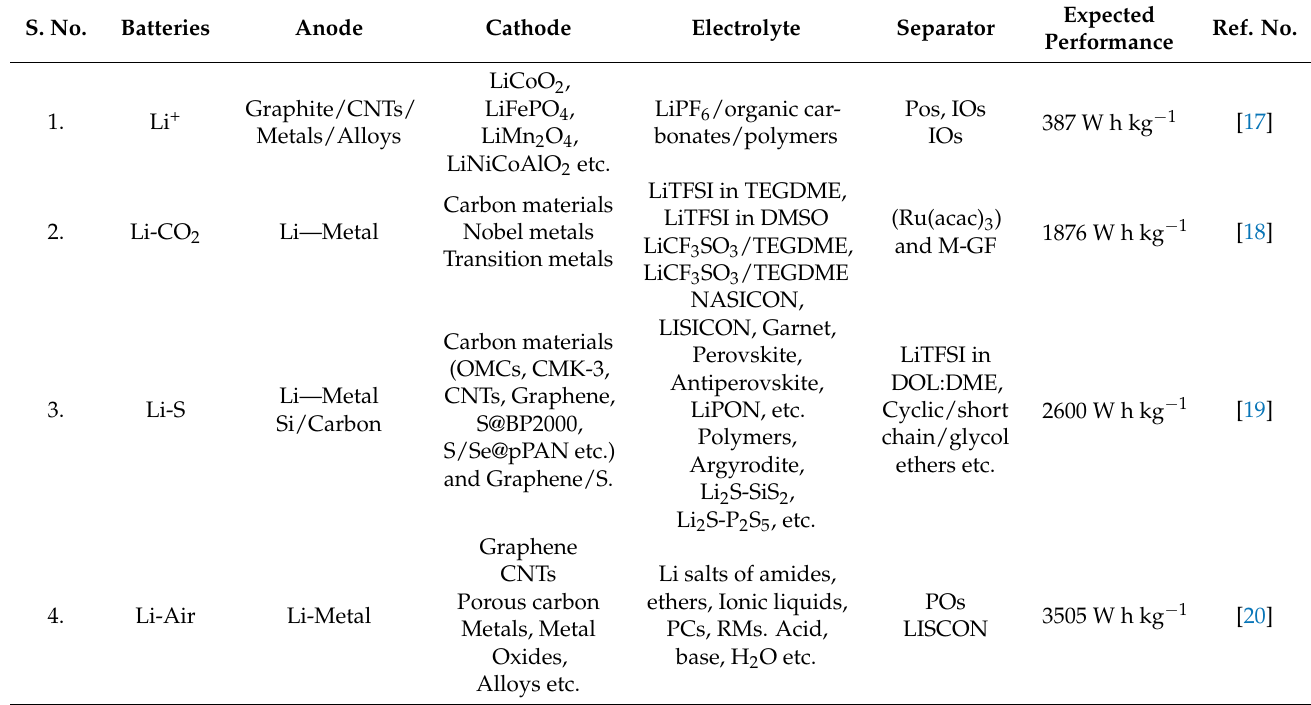
Table 1. Comparison of the best performing Li based